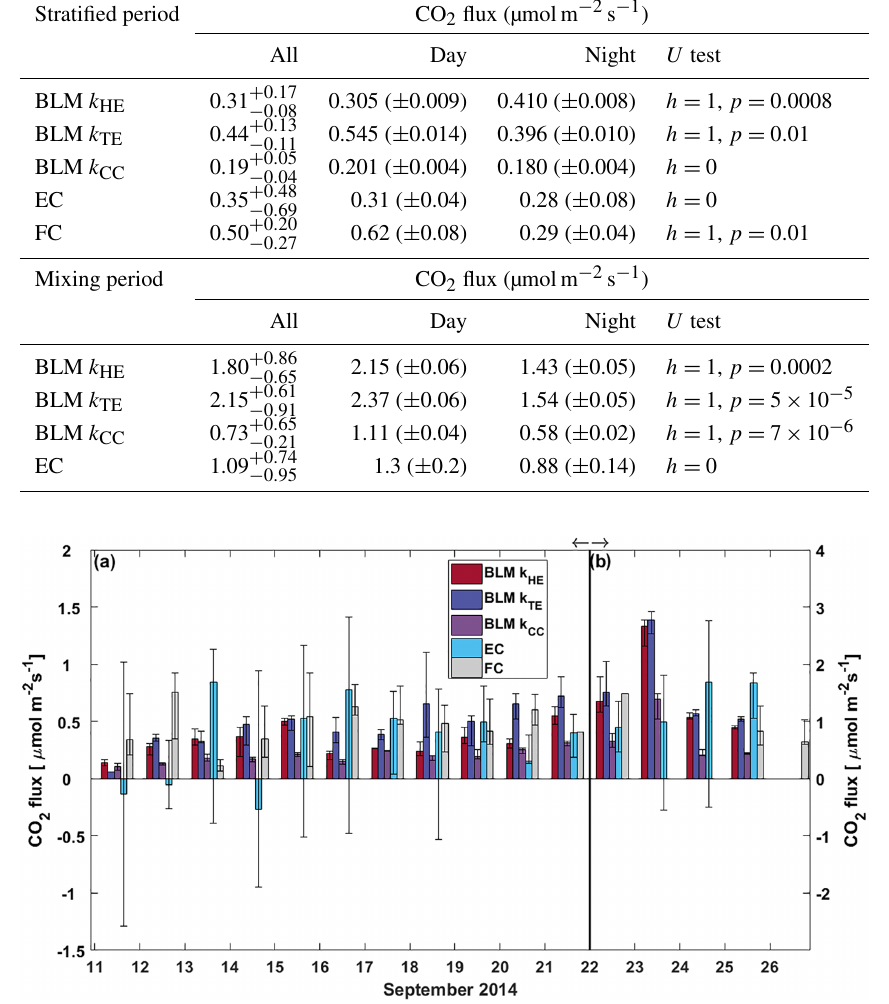
Figure 6. Daily median CO 2 flux from BLM, EC and FC methods. The black whiskers indicate the 25th and 75th percentiles, respectively. The vertical black line represents the start of the lake mixing period. Fluxes during (a) the stratified period (11–21 September) are read from the left and (b) mixing period fluxes (22–26 September) from the right y